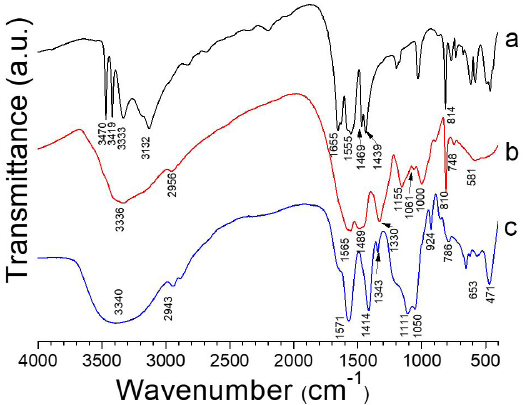
Figure 2. FTIR spectra of (a) melamine, (b) PMF, and (c) PMF-Si composite. Figure 3. XRD of melamine, SiO